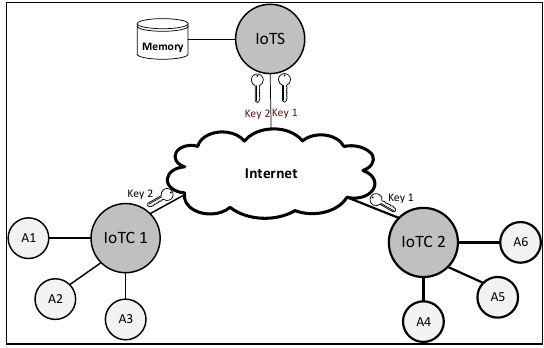
Figure 1. Global Scheme of the targeted IoT (Internet of Things) application.